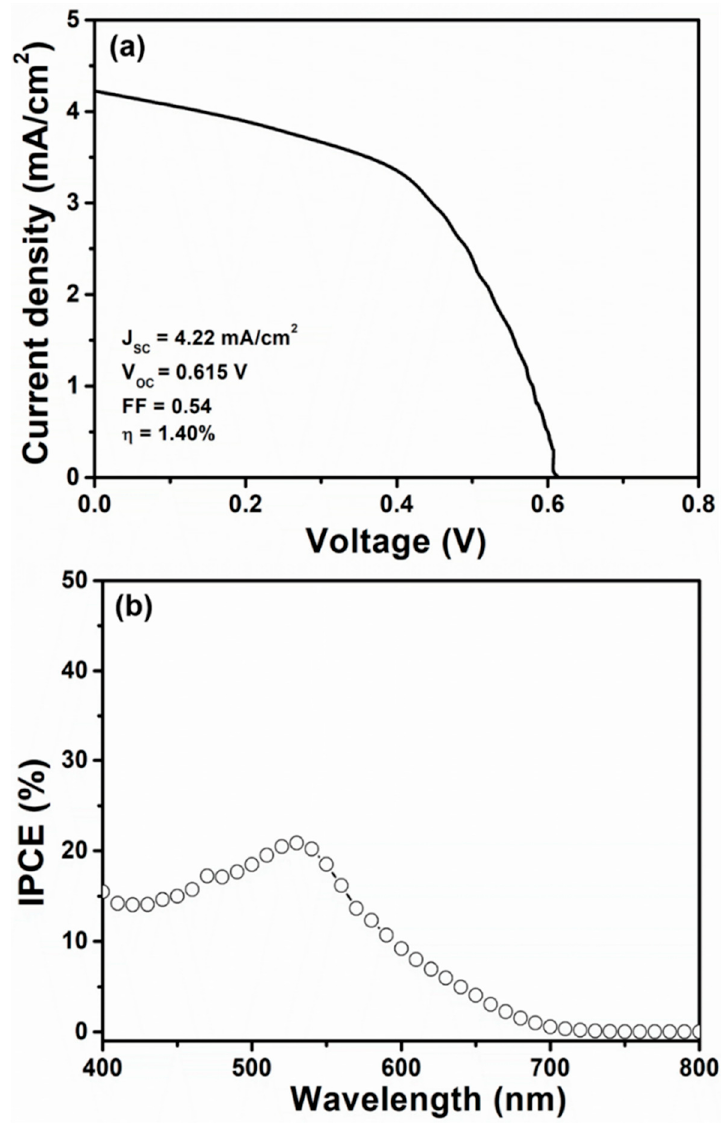
Figure 6. Typical ( a ) current density-voltage ( J – V ) characteristics and ( b ) incident photon-to-current conversion efficiency (IPCE) curve of manufactured dye-sensitized solar cells (DSSCs) with flower- shaped ZnO nanostructures based